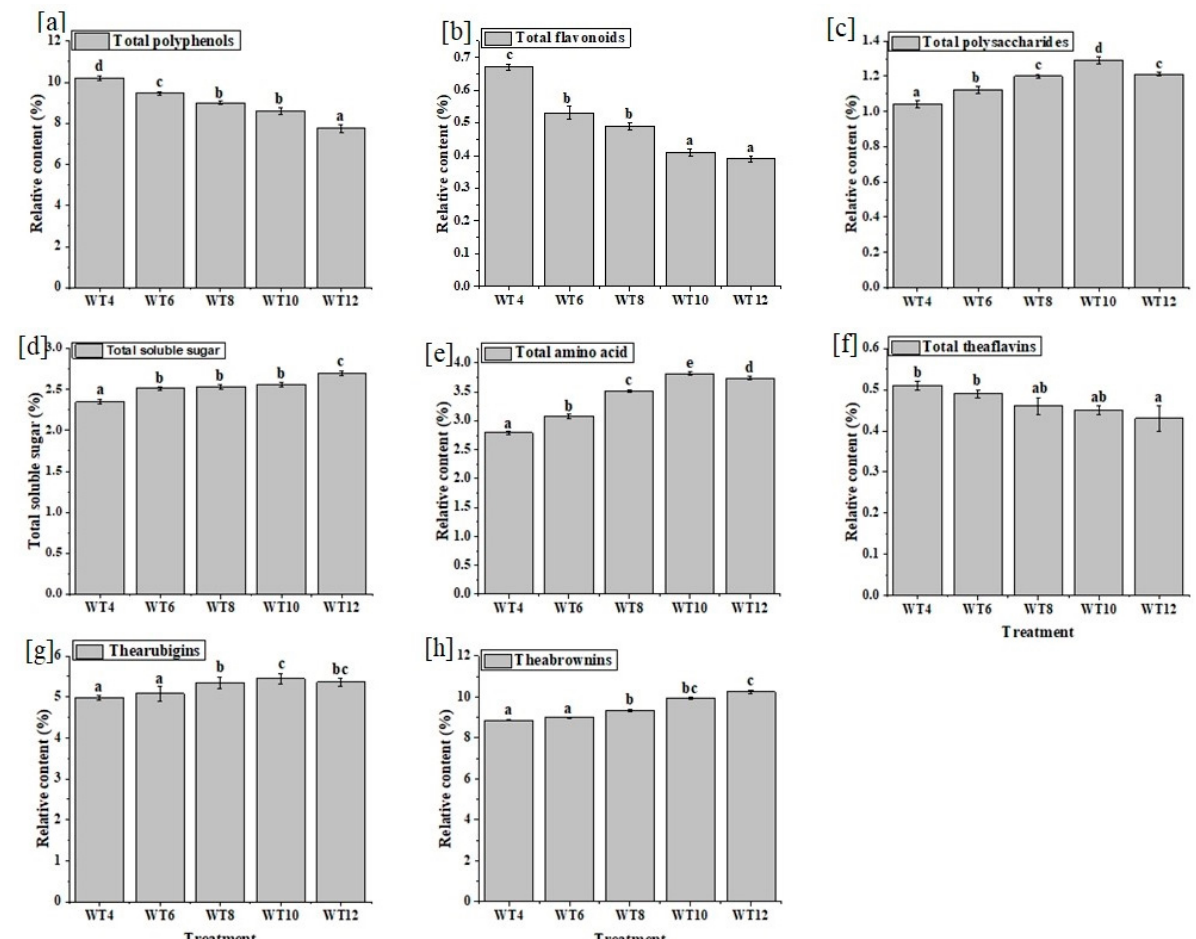
Figure 2. The relative total content of ( a ) polyphenols, ( b ) flavonoids, ( c ) polysaccharides, ( d ) soluble sugars, ( e ) amino acids, ( f ) theaflavins, ( g ) thearubigins, and ( h ) theobrownins. The different superscripts show significant differences ( p < 0.05) according to Duncan’s test.